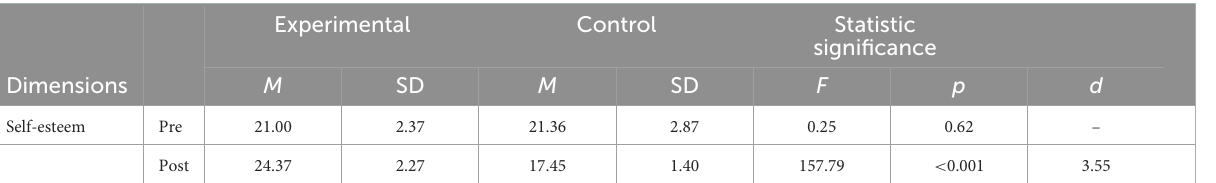
TABLE 5 Means and standard deviations in self-esteem variable of pre- and post-treatment groups: a posteriori contrasts.